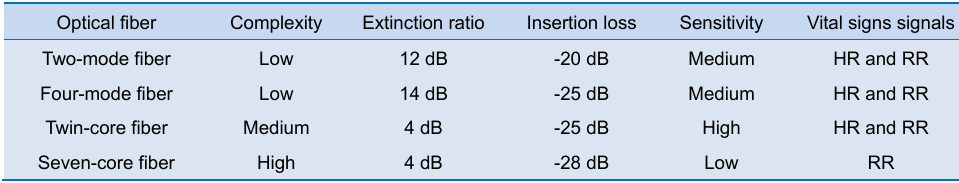
Fig. 12 | Post-exercise physiological activities characterization results using the TCF in-line interferometer, including the recovered heartbeat waveform (a) and respiration waveform (b) and calculated HR and RR. Table 1 | Performance comparison of FMF and MCF on vital signs monitoring.